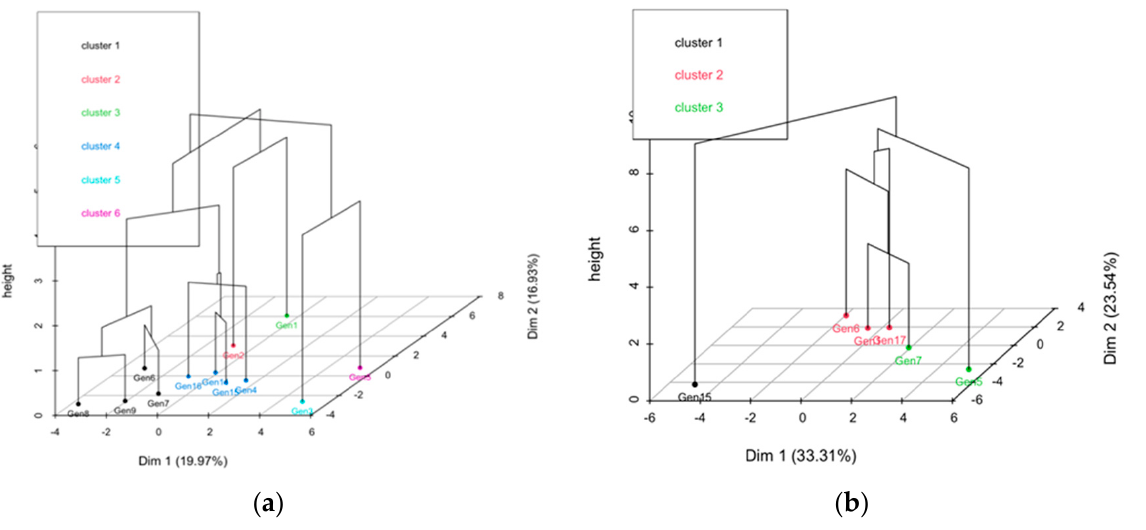
Figure 7. Cluster analysis showing the conformation, taking into account the quantitative and qual- itative variables evaluated in 12 genotypes of yellow pitahaya in ( a ) open fields and ( b ) under cover. The second cluster grouped genotypes 1, 6, and 17, which were characterized by higher values of titratable acidity (TA) of 0.20, 0.21, and 0.24, respectively. The genotypes with the lowest fruit weights (161.5 g and 199.16 g) were genotype 6 and genotype 17. Likewise, genotypes 6 and 17 had mostly dark gray areolas (CAR) of 80% and 70%, respectively. In that generated this association between the genotypes was titratable acidity (Table